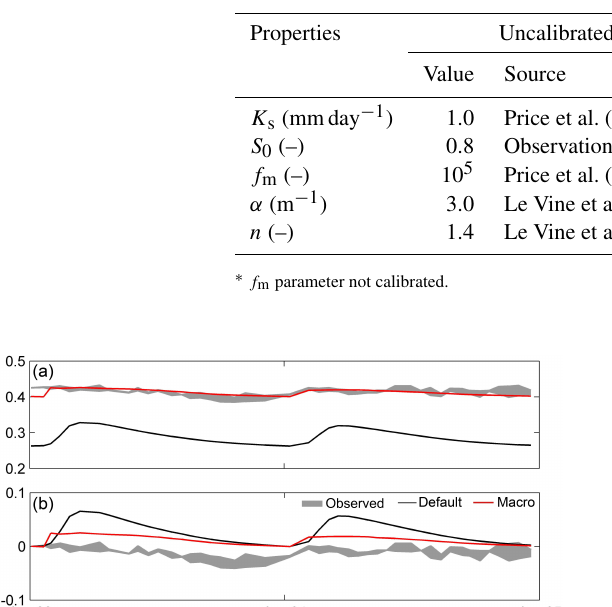
Table 3. Hydraulic properties of chalk.